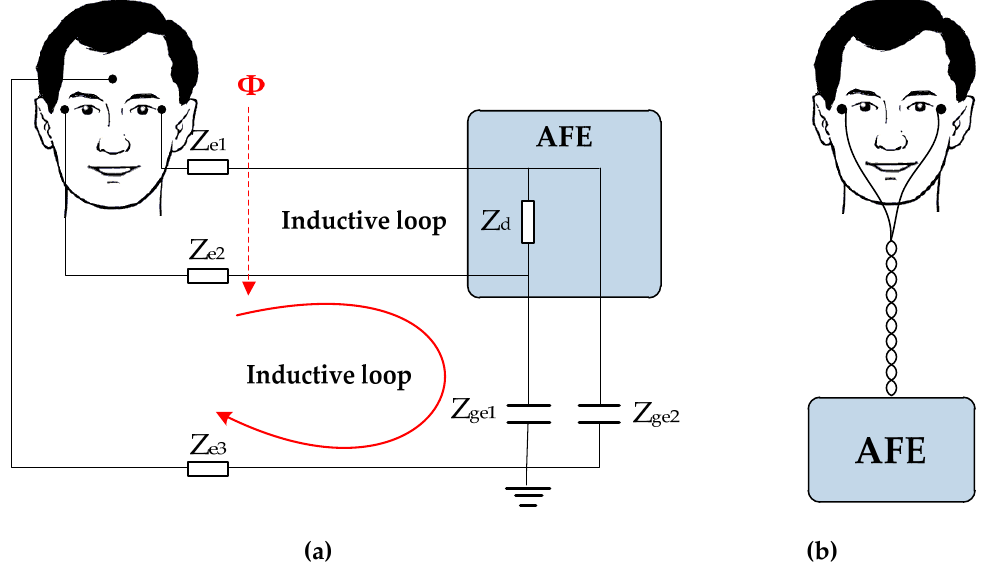
Figure 7. ( a ) Inductive loop present in the measurement system; ( b ) Reduction of magnetic interferences by twisting the wires of the electrodes.